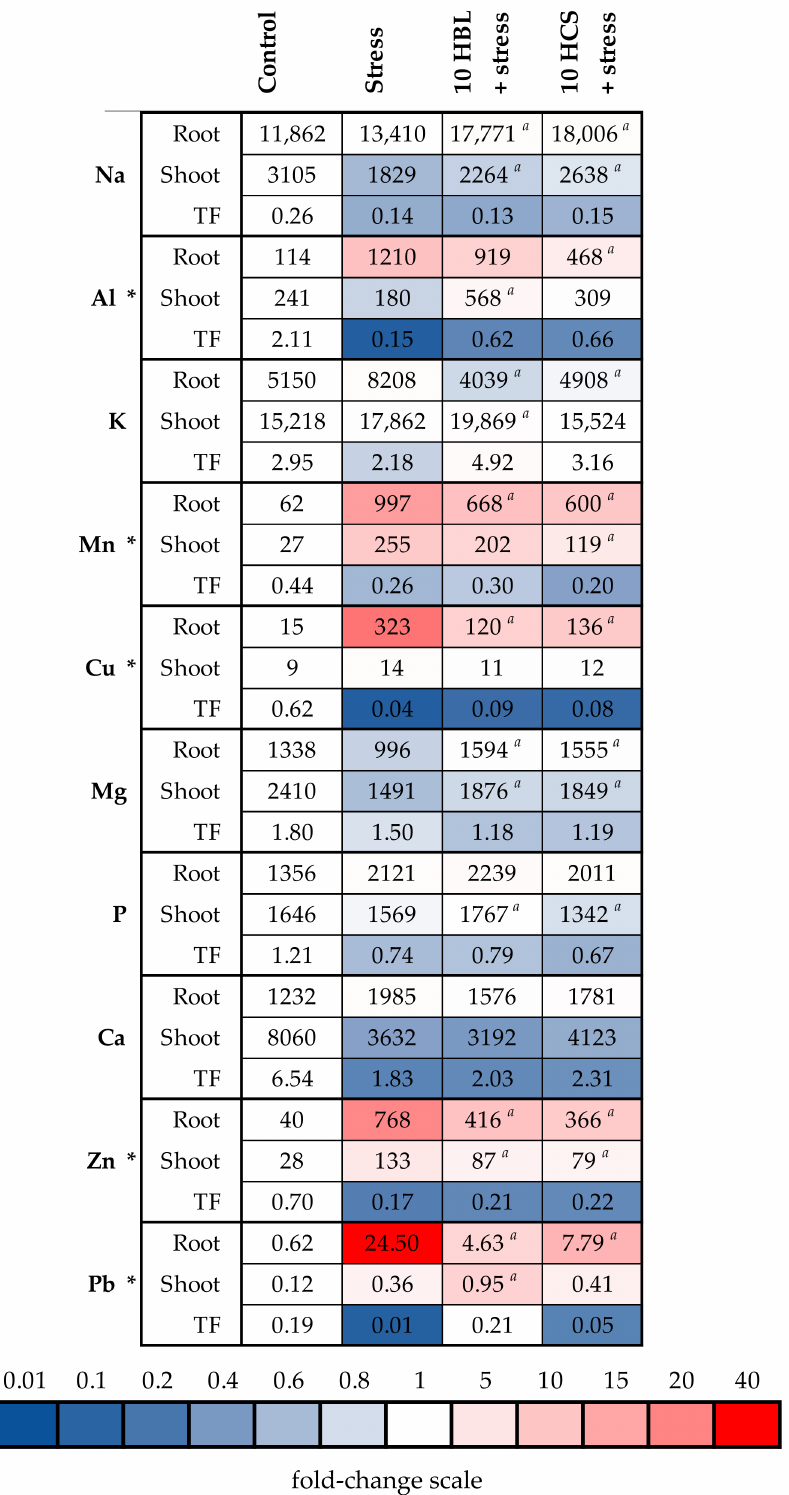
Figure 5. The effects of heavy metal stress and treatment with brassinosteroids on the elemental content ( µ g/g dry weight) and translocation factors in barley plants. The value in the control plants was taken as 1.0, the relative decrease is indicated in blue, the relative increase is indicated in red. TF—translocation factor. Asterisks (*) indicate significant differences from the control variant, and the a letter indicates significant differences from the polymetallic stress-treated variant ( p <